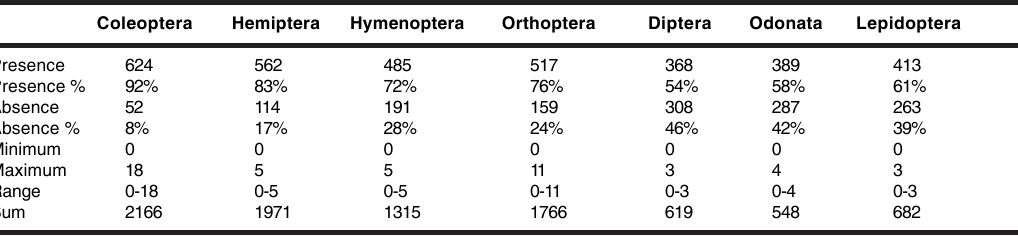
Table 6. Comparative statistics for different prey items found in the Black Drongo pellets